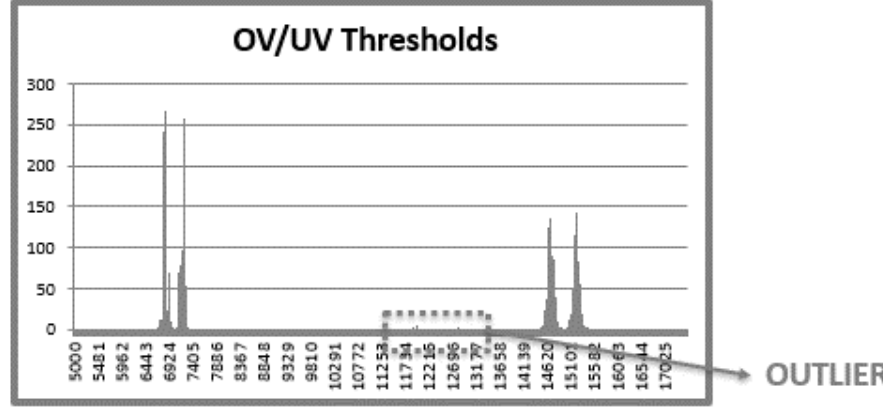
Figure 10. Anomalies in the OV/UV test.